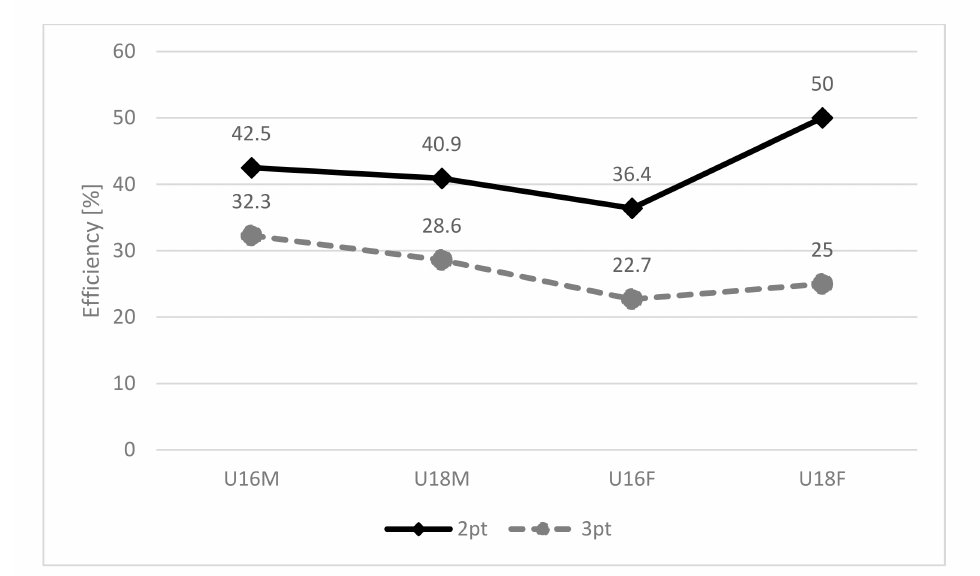
Figure 3. Efficiency of 2-pt and 3-pt shooting in individual